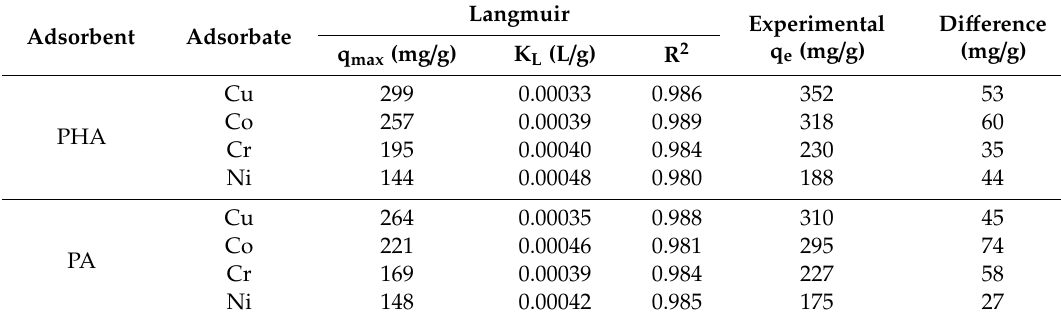
Figure 12. Langmuir isotherm curves obtained by linear fitting on the adsorption of metal ions metal by the jute cellulose-based polymer ligands: ( a ) represent PHA and ( b ) represent PA ligand; experimental variables: 0.5 g of ligands (PHA or PA), 15 mL of distilled water, 5 mL of pH 6 buffer solution, 5 mL of 0.2 M synthetic metals ions solution and stirred for 2 h . Table 3. The linear form of Langmuir isotherm parameters for polymer adsorbent, PHA /